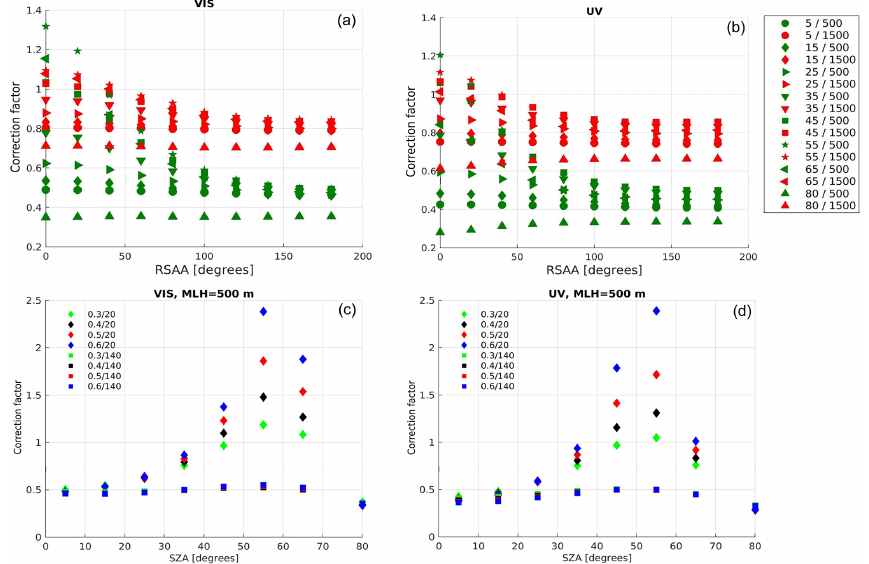
Figure 2. Panels (a) and (b) correspond to the correction factors as a function of RSAA for two different MLH values (in every RSAA and MLH value, the different data points correspond to different SZA values) in the visible and UV wavelength ranges. The first value in the list of symbols corresponds to the SZA and the second to the MLH. Panels (c) and (d) show the correction factors as a function of SZA for different AOD scenarios and RSAA values in the visible and UV ranges for an MLH set to 500m. The first value in the list of symbols corresponds to the AOD and the second to the